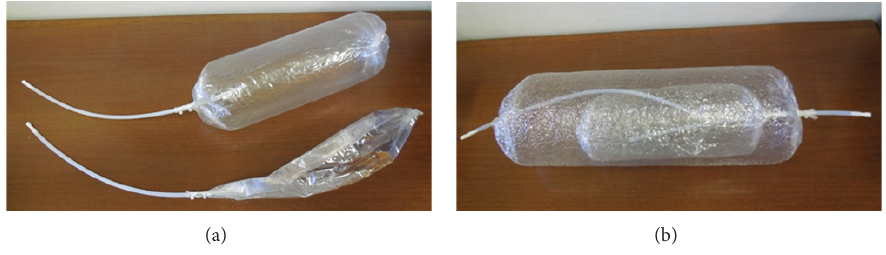
Figure 1: Nalophan bags: (a) single bag and (b) double